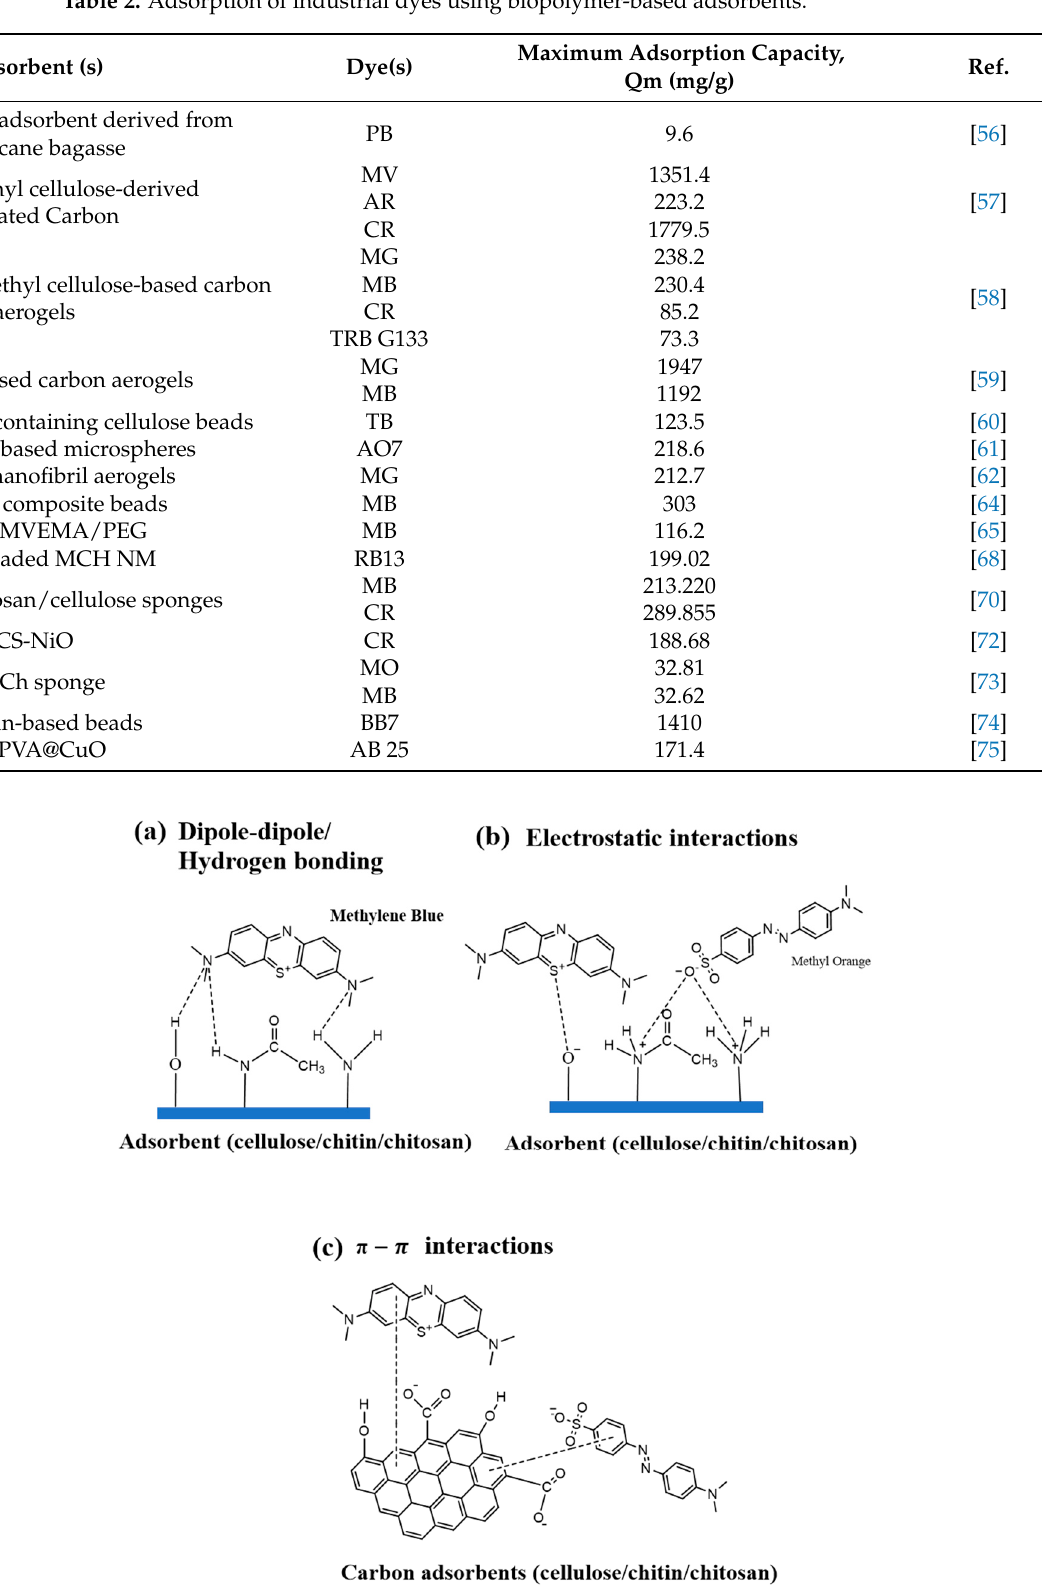
Table 2. Adsorption of industrial dyes using biopolymer-based adsorbents. Adsorbent (s) Dye(s)